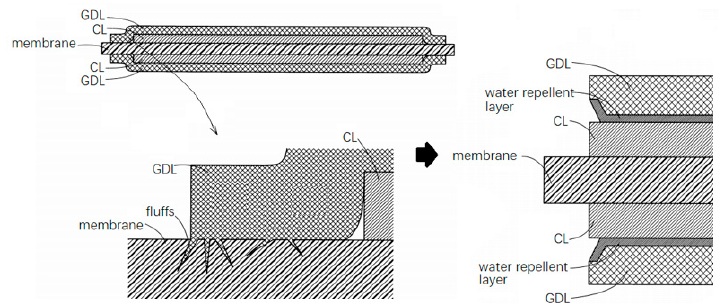
Figure 9. Measures to avoid stray fiber damage [90].